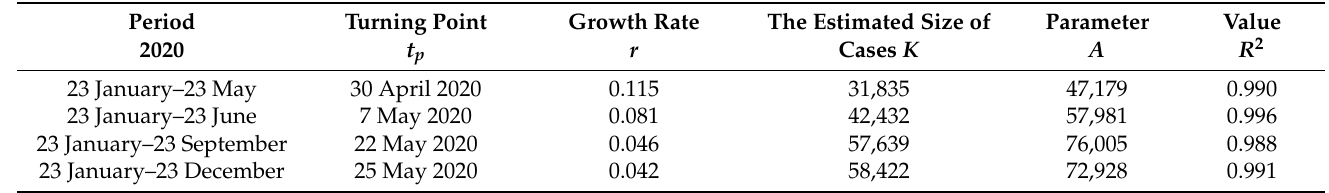
Table 2. The estimation results of parameters in the logistic growth model for various periods from daily cases data of COVID-19 infected in Singapore based on data compiled by WHO [18].